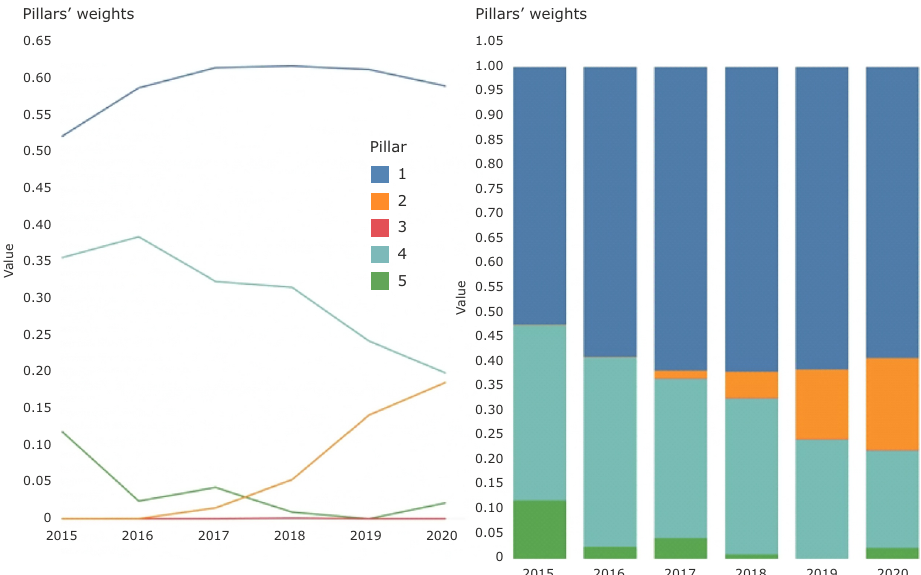
Figure 10. Optimized weight for